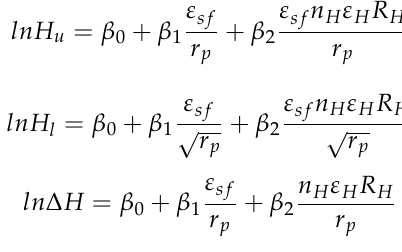
Figure 8. Snapshots showing simulated 0.95 nm pores at 25 °C: ( a ) PW 1 pores at a series of H from top to bottom: 0.000036%, 0.00050%, 0.16%, 0.35%; ( b ) PW 2 pores at a series of H from top to bot- tom: 0.000036%, 0.60%, 5.57%, 6.34%. Each green ball with attached two magenta balls represent one water molecule, and blues spheres show the position of sorption sites.